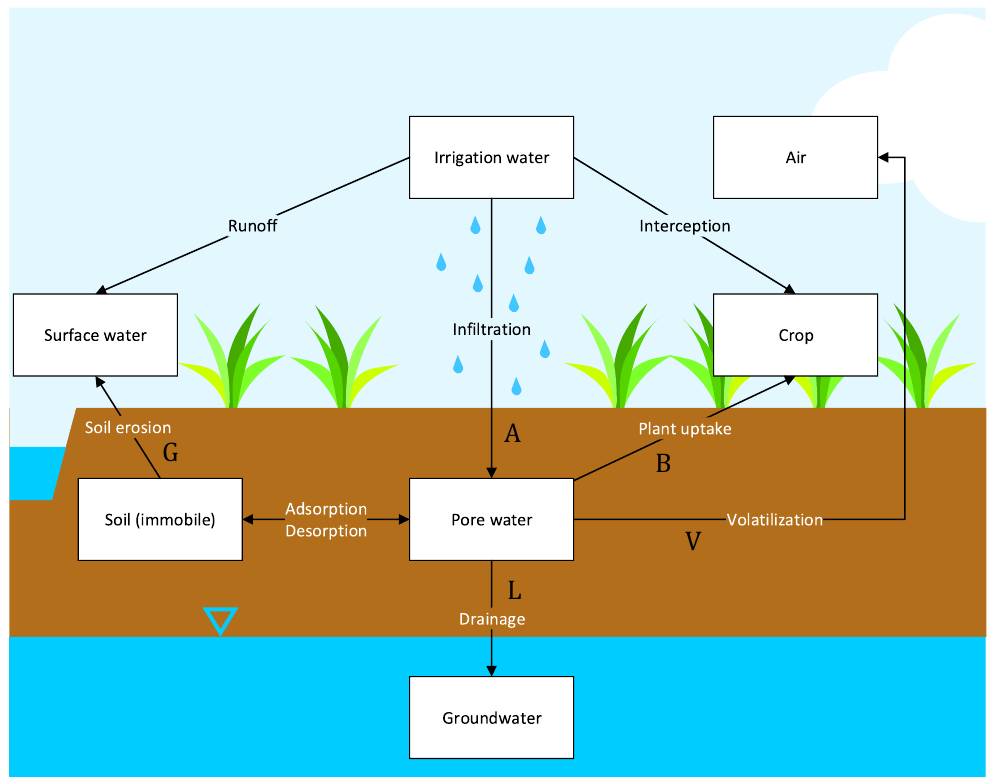
Figure 1. A schematic representation of various environmental compartments relevant to irrigation with marginal water, indicating the possible contaminant pathways between compartments. Accumulation of contaminants in each end compartment can cause risks for public health and the